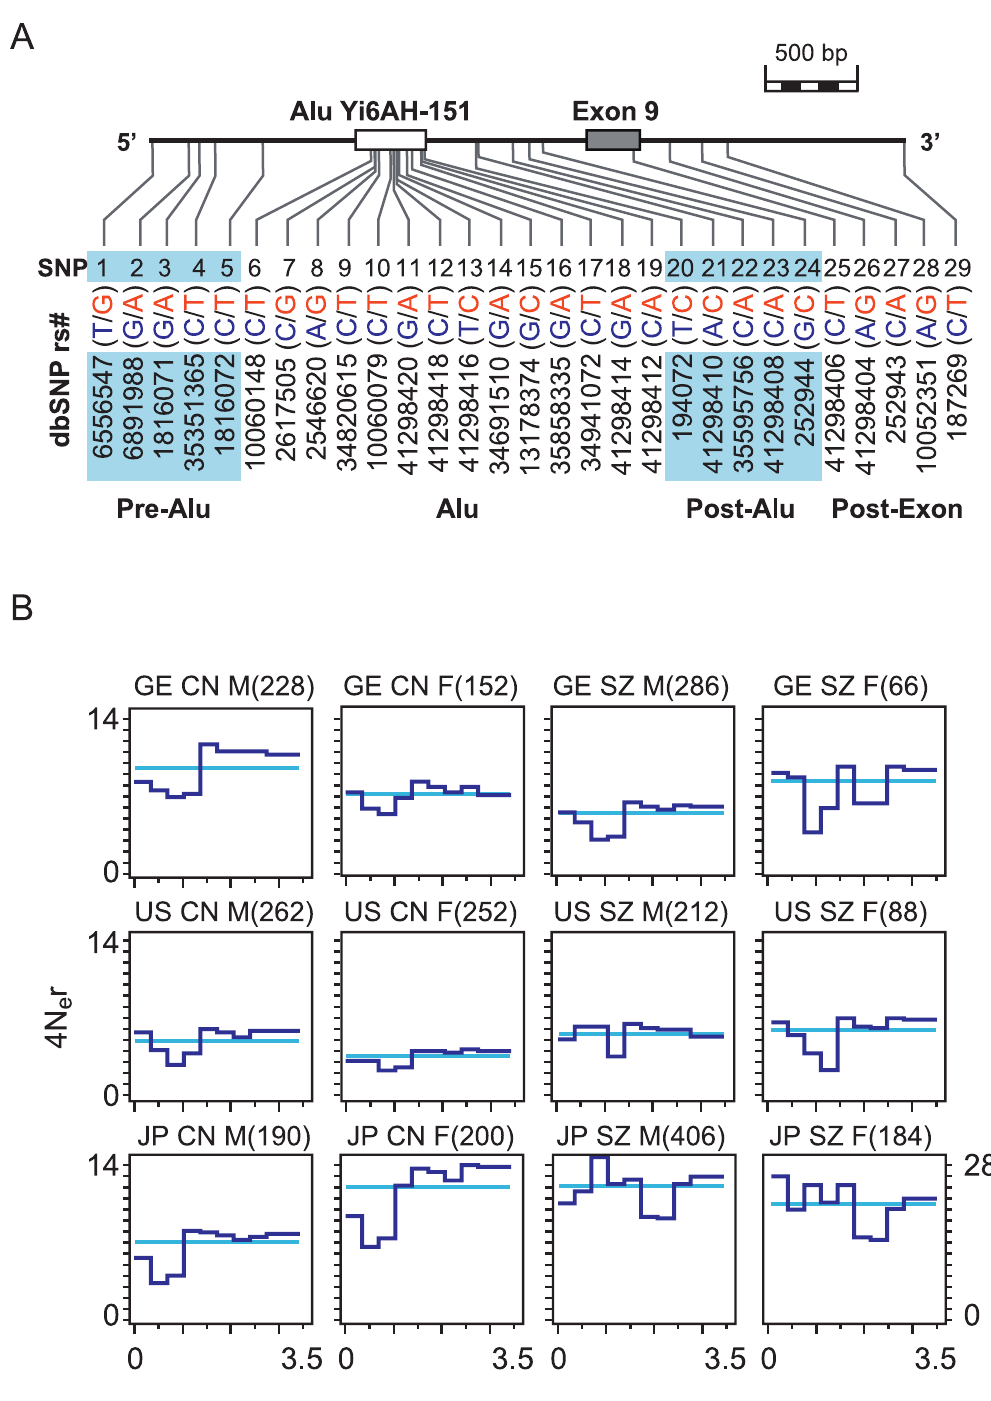
Figure 1. Distribution of SNPs and recombination rate in the S1-S29 segment of GABRB2 . (A) Locations and allelic forms (blue for ‘ancestral’ and red for ‘derived’ as described in [11]) of SNPs in the S1–S29 segment (chromosome 5q34, 160,689,203-160,692,753 bp). (B) Population recombination rates estimated by Hotspotter. The profile of the estimated population recombination rate is shown as r hat (‘‘rhohat’’ output from Hotspotter shown in dark blue), or the estimated average population recombination rate r bar (‘‘rhobar’’ output from Hotspotter shown in light blue). The JP SZ-F cohort gave a r bar value of 21.3, corresponding to a recombination rate of 15.0 cM/Mb. The number of chromosomes analyzed in the control (CN) or schizophrenic (SZ) male (M) or female (F) German Caucasian (GE), American Caucasian (US) or Japanese (JP) cohort is indicated by the number inside parentheses following cohort identification.